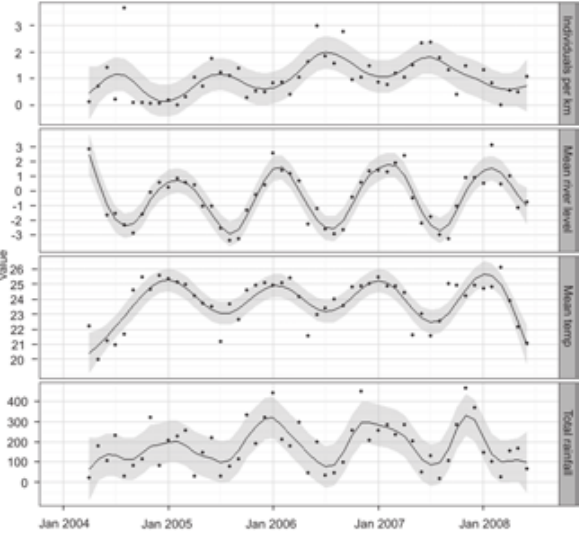
Figure 2. Monthly patterns in P. unifilis abundances and abiotic factors around the Los Amigos Biological Station, Amazonian Peru, from April 2004 to August 2008. Solid black lines and grey shaded areas show predicted values and confidence intervals obtained from generalized additive models, grey dots are the observed